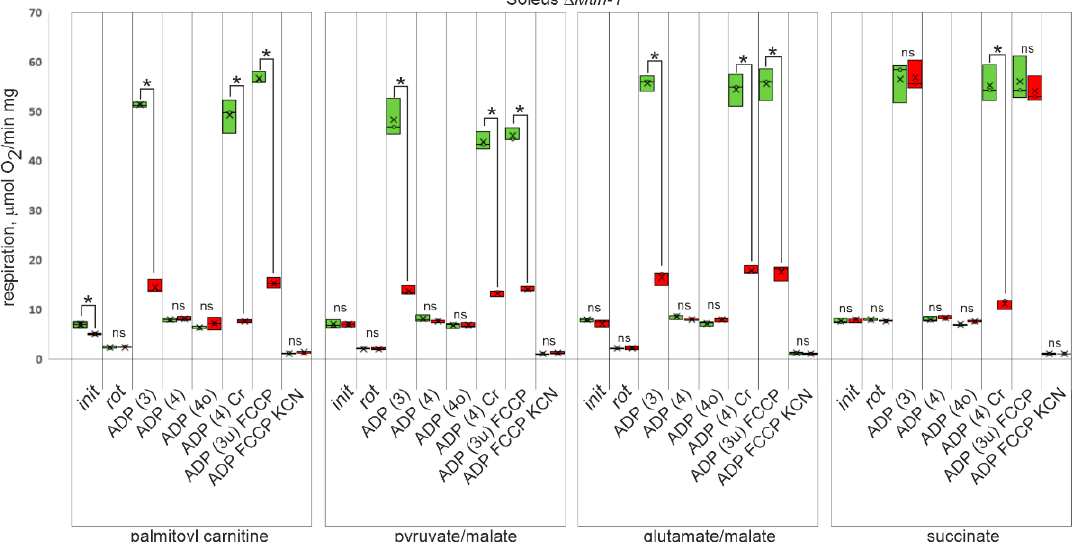
Figure 2. In fl uence of Mtln gene inactivation on respiration of muscle mitochondria. Oxygen consumption rate (OCR) of soleus muscle mitochondria extracted from the wild type (green bars, n = 3) and Δ Mtln-1 (red bars, n = 3) male mice. The groups of bars correspond to the respiration on palmitoyl carnitine (CI+CII+ETF activity), pyruvate and malate (CI activity), glutamate and malate (CI activity) and succinate (CII activity) as marked below the graphs. The experimental points measured are substrates alone (init), substrates with rotenone (rot), substrates and ADP (ADP (3)), substrates after exhaustion of ADP (ADP(4)), substrates after exhaustion of ADP after addition of oligomycin (ADP (4o)), substrates after exhaustion of ADP (ADP(4)) following addition of creatine, substrates after exhaustion of ADP after addition of oligomycin and FCCP uncoupler (ADP (3u) FCCP), resid- ual respiration after inhibition of uncoupled respiration by potassium cyanide. Interquartile ranges are shown as solid bars, while the all-data range is shown by thin lines. The horizontal line corre- sponds to the median, while the cross is the average. The signi fi cance level calculated using the Student’s t -test is shown. If a p -value is less than 0.05, it is fl agged with one star (*).